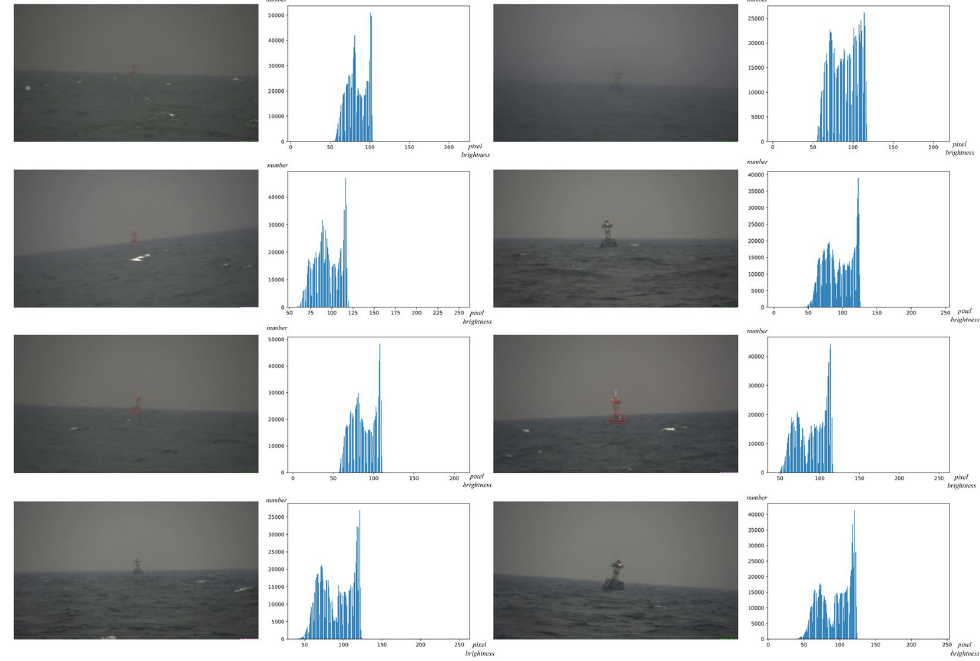
Figure 3. Fog-free image at sea and its grayscale histogram.